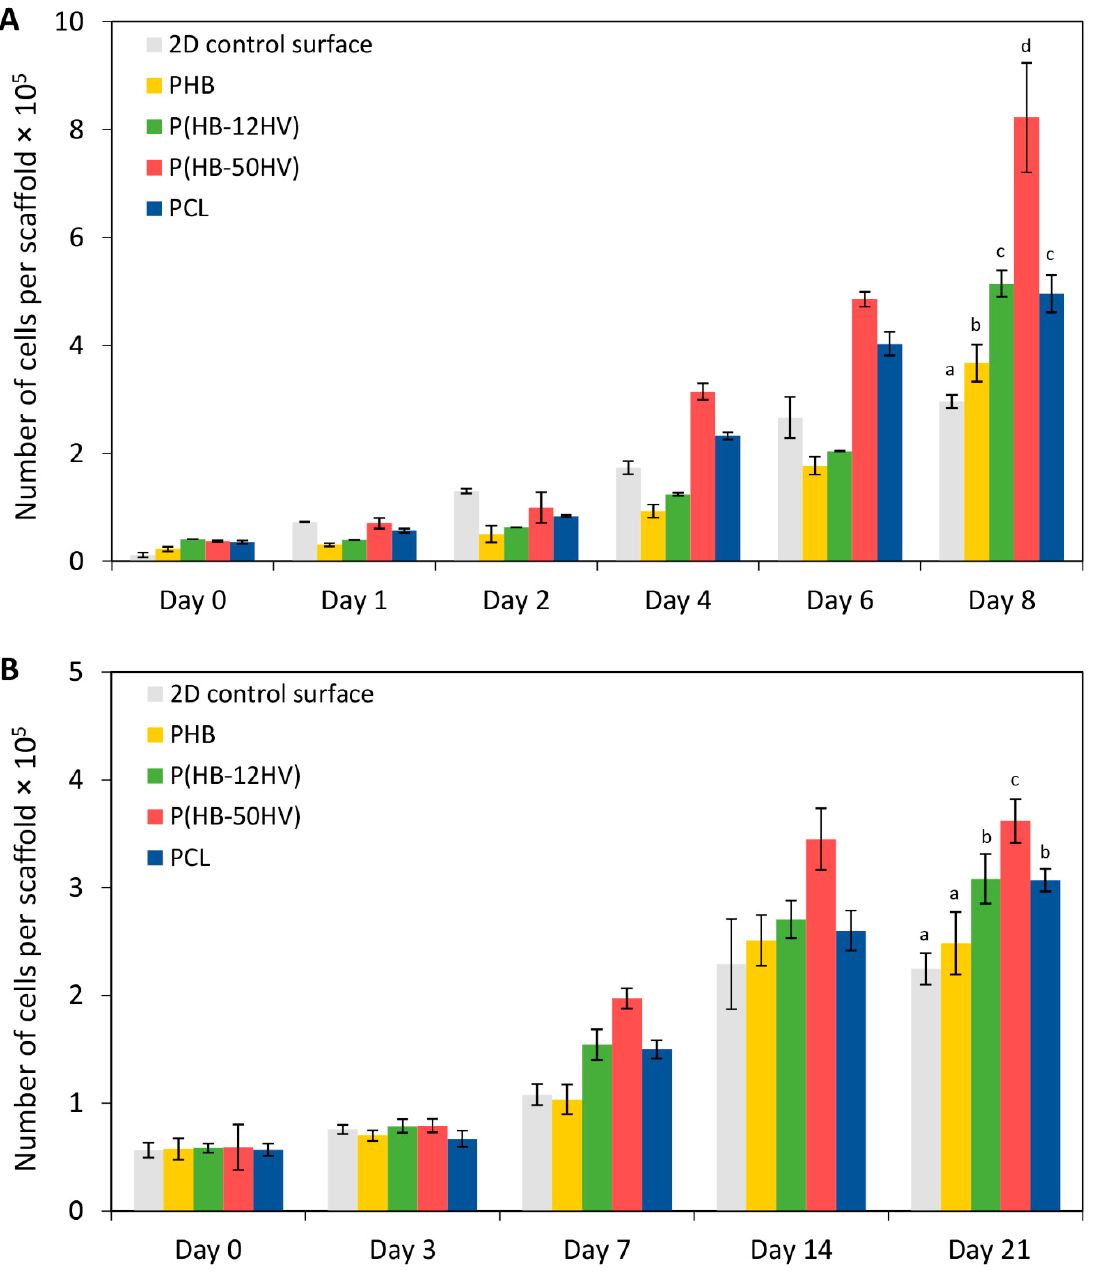
Figure 5. Cell proliferation of ( A ) HGF and ( B ) PDLSC cells grown on different types of 3D porous scaffolds. The values are the means with standard deviation derived from three independent scaffolds ( n = 3). Bars labeled with different letters (a, b, c, and d) indicate significant differences within the same day ( p < 0.05).